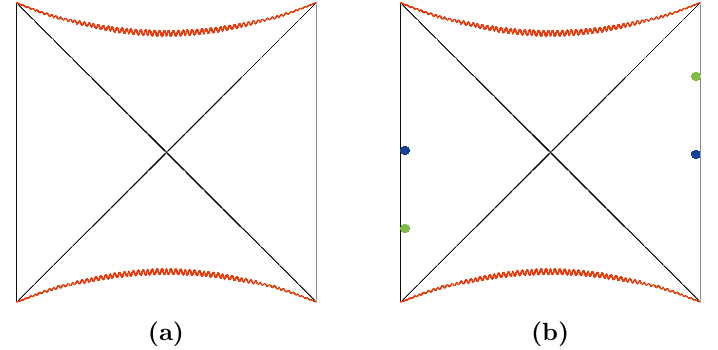
Figure 1. a) The Penrose Diagram of the eternal black hole. b) The blue dots correspond to operators which are entangled. An operator at a later time, green dot, is entangled with an earlier operator on the other